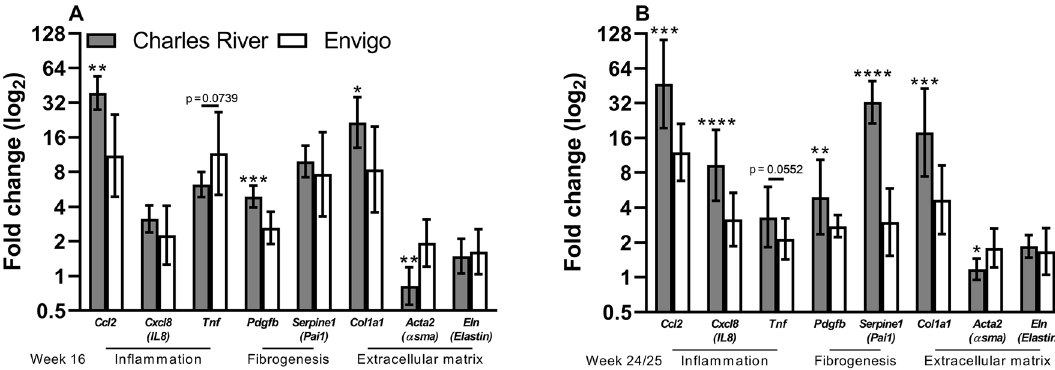
Figure 5. Hepatic gene expression in animals with NASH. Gene expression in liver samples from animals with NASH from Charles River or Envigo relative to healthy to control from the respective breeders. ( A ) At week 16, most genes were statistically significant or normally increased in animals from Charles River compared Envigo. ( B ) At week 24/25, this effect was even more pronounced with animals from Charles River displaying clear increases in genes related to inflammation, fibrogenesis and extracellular matrix composition. Mean fold changes with ranges. The scale of the y-axis is log 2 . Analysed by unpaired t-test or Welch’s t-test in case of heterogeneous variance. *p < 0.05 **p < 0.01 ***p < 0.001, ****p < 0.0001 compared to Envigo animals. αsma α smooth muscle actin, Acta2 actin alpha 2, Ccl2 Chemokine (C-C motif) ligand 2, Col1a1